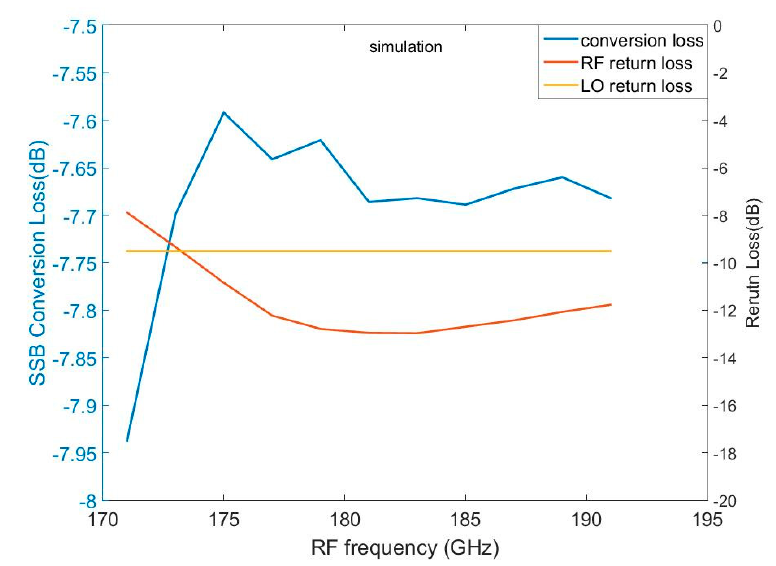
Figure 7. Simulated SSB conversion loss and return loss of mixer 2.